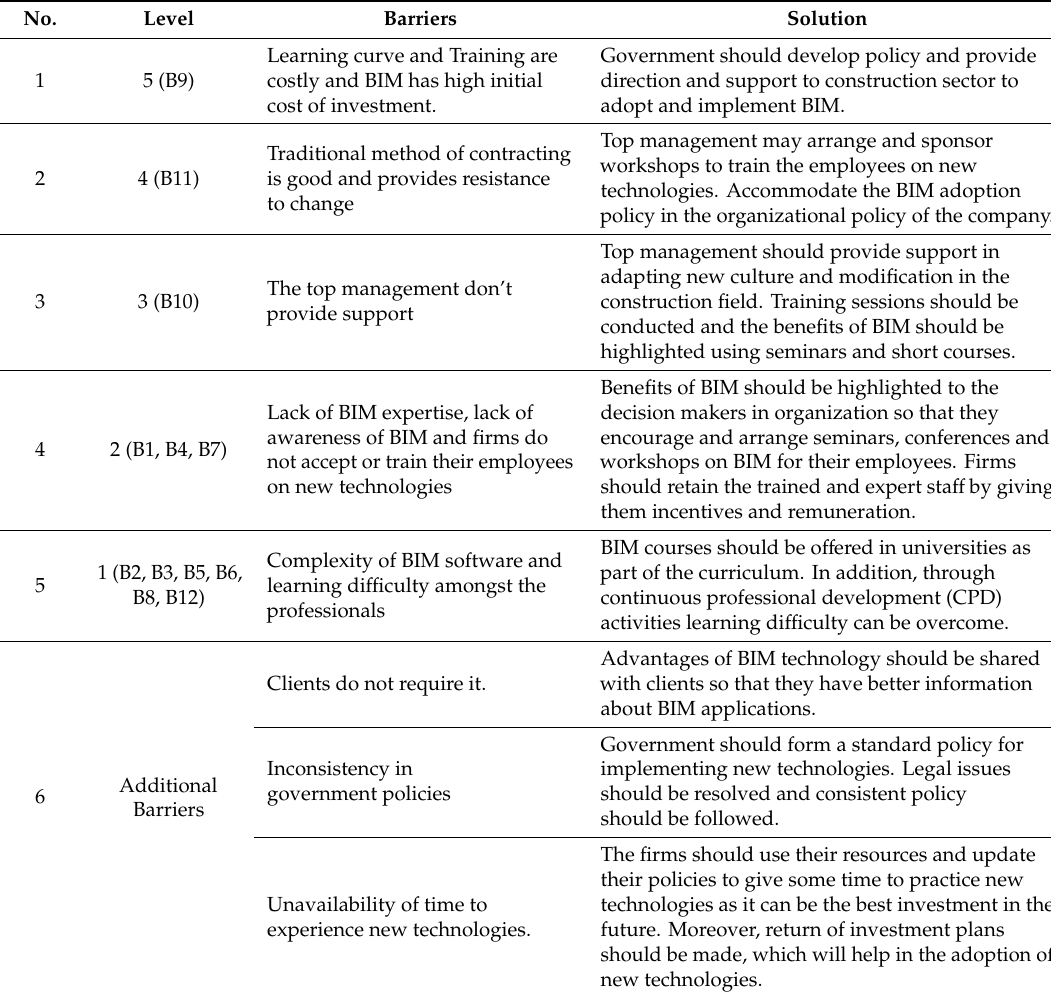
Table 12. Solutions to overcome various barriers in di ff erent construction markets around the